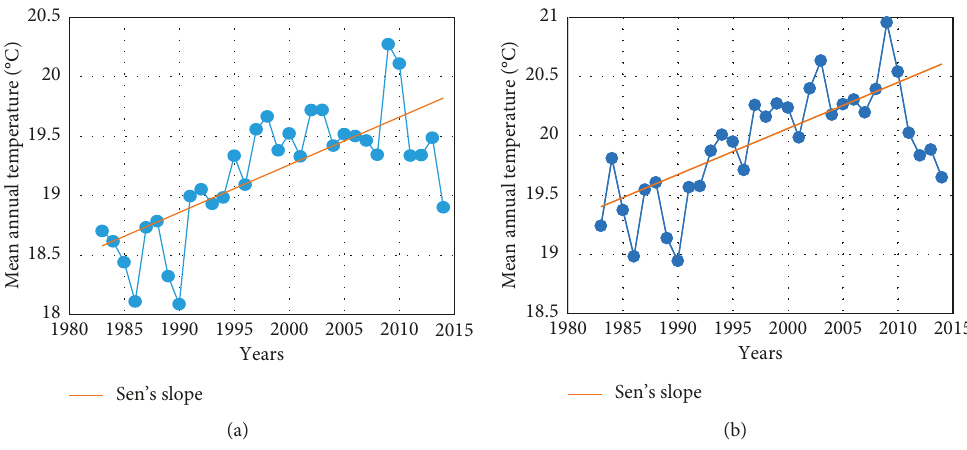
Figure 3: Mean annual temperature trends for (a) Hawzen and (b) Irob districts during